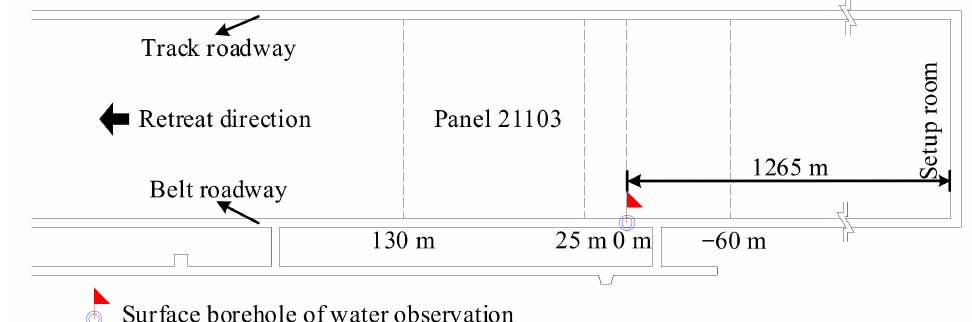
Figure 11. Piezometer position with respect to LW21103 workings.